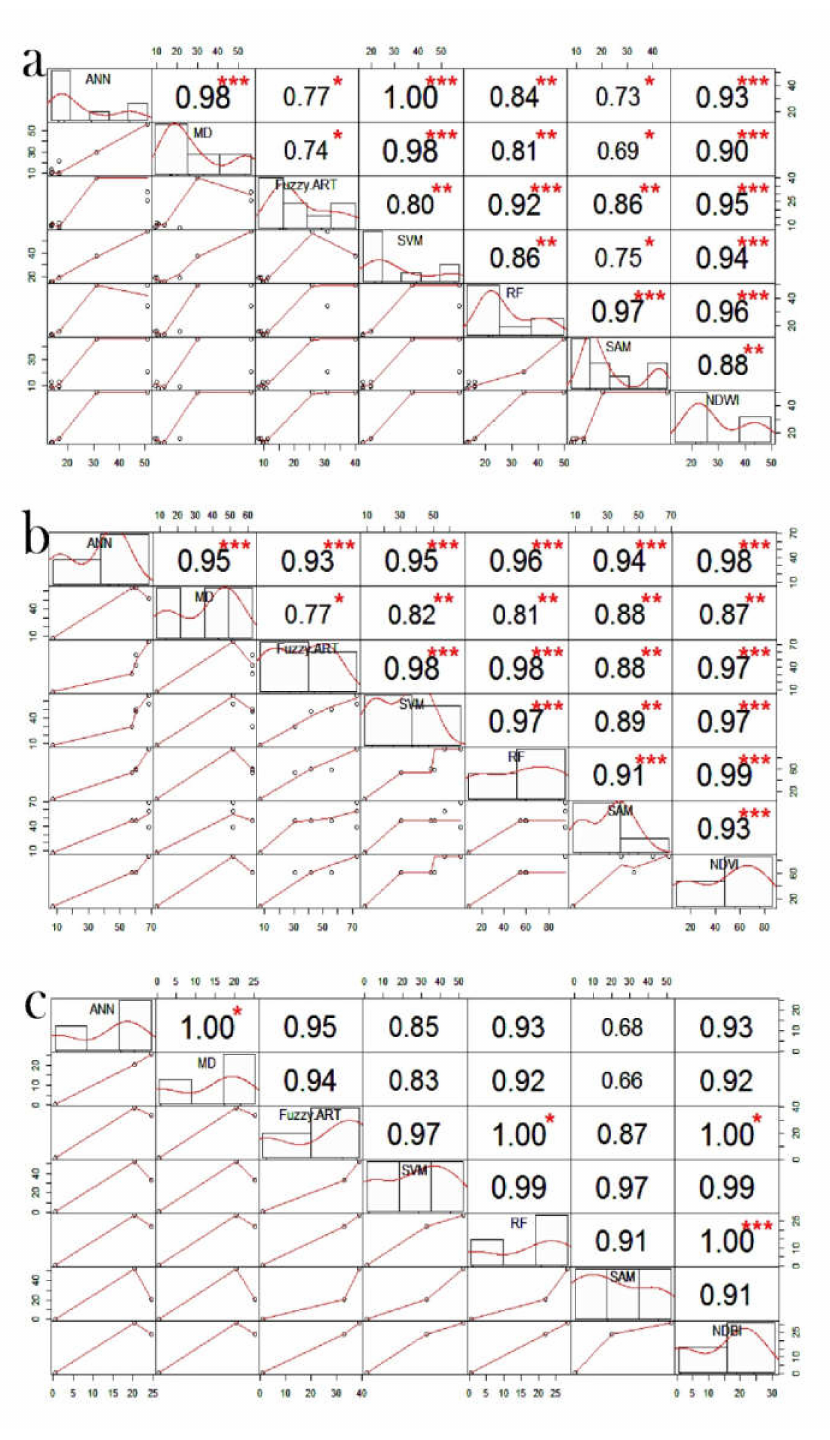
Figure 6. The correlation among the six LULC classifiers and satellite data-derived indices (NDWI, NDVI and NDBI) for ( a ) window 1, ( b ) window 2, and ( c ) window 3. (*, ** and *** are the significant levels at 0.001, 0.01, and 0.05,